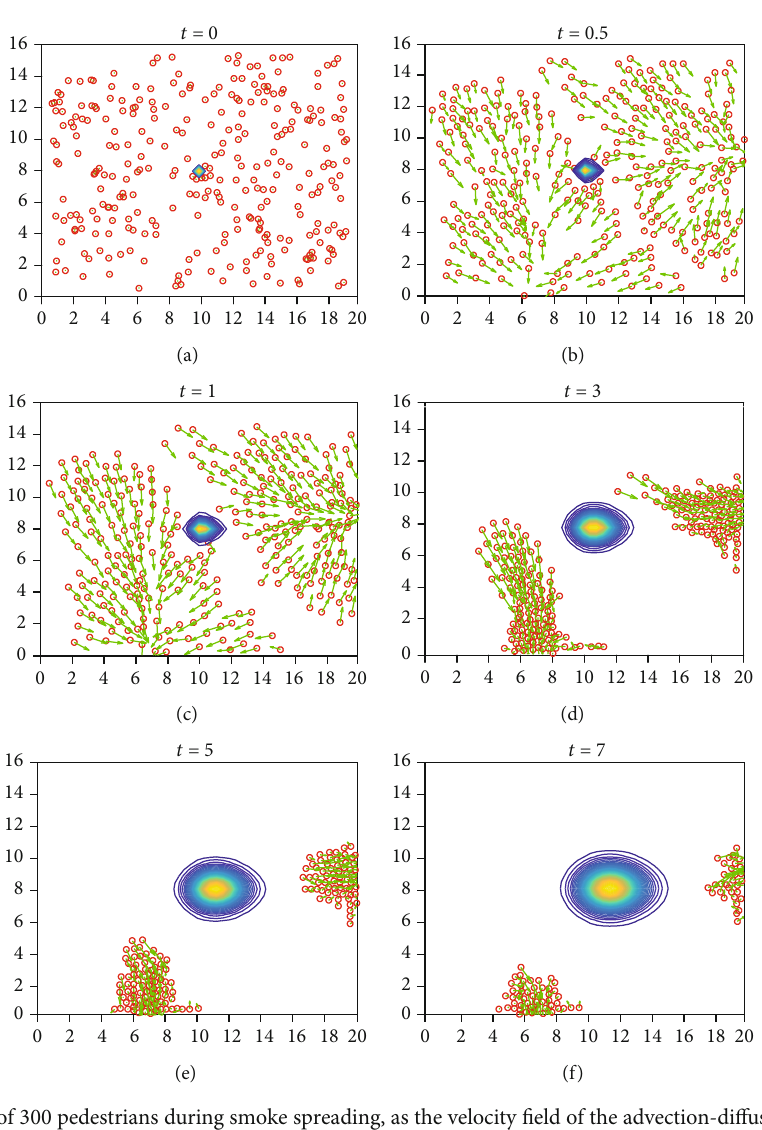
Figure 6: The movements of 300 pedestrians during smoke spreading, as the velocity fi eld of the advection-di ff usion is ð w equation (13) and the source is in the middle of the room.